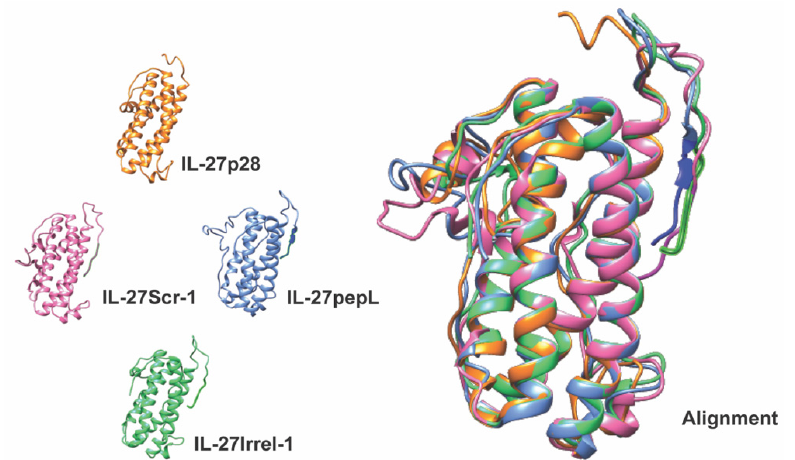
Figure 2. In silico modeling and alignment shown for the most-distal C-terminal portion of Nluc-27, consisting of the native IL27p28 subunit, a short linker (GGGGS), and each of the control (scr1 or irrel1) or targeted (pepL) peptides. All C-terminal peptide sequences used were predicted to be solvent exposed.